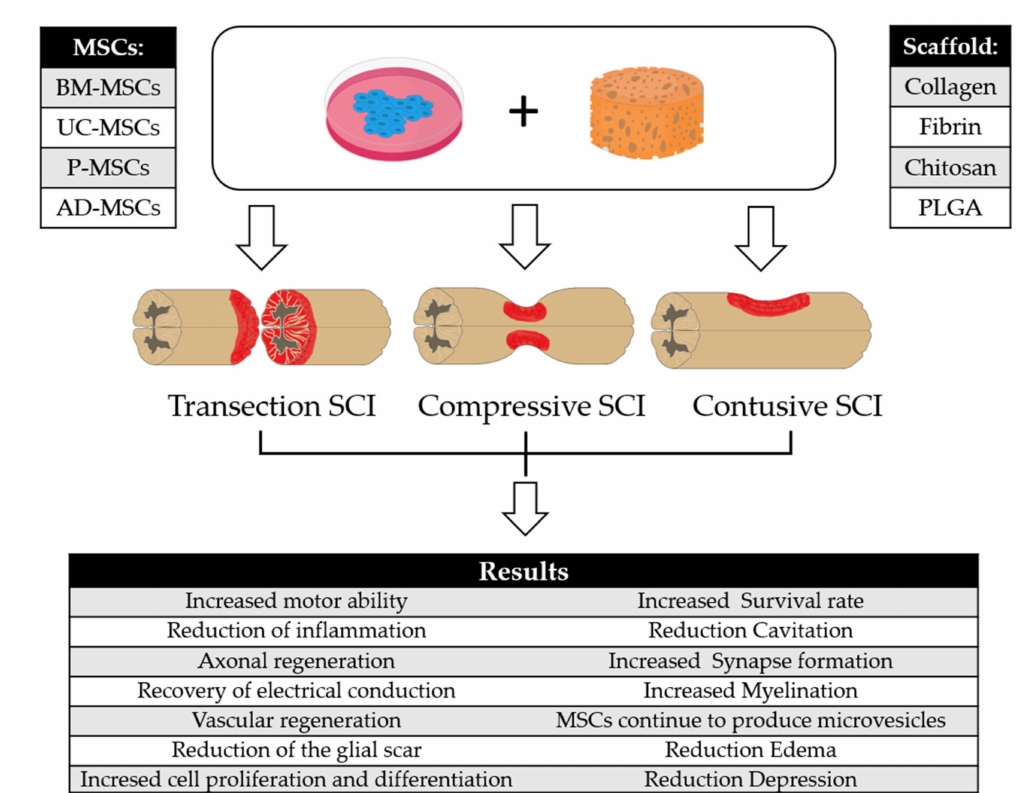
Figure 1. Results obtained using different types of MSCs combined with different